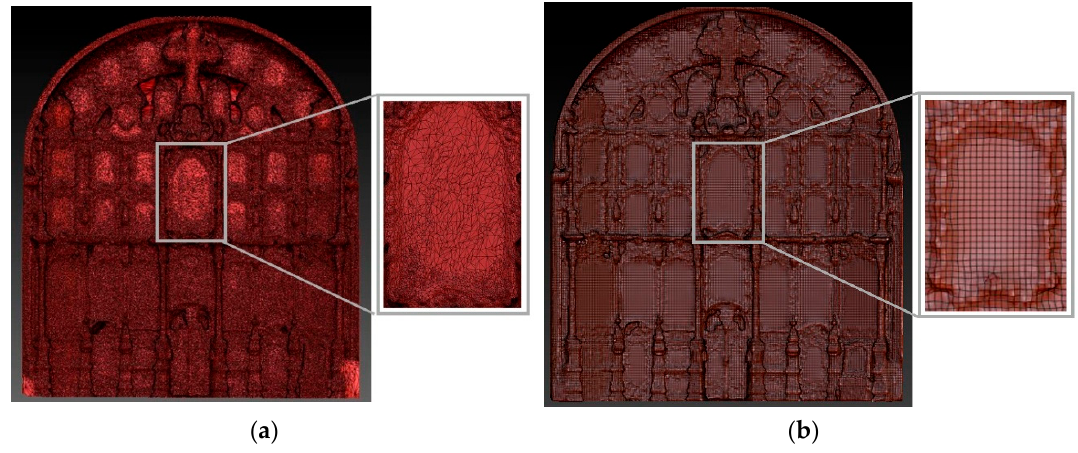
Figure 3. (a ) High-poly 3D model of the iconostasis and the detail of the polygon mesh; ( b ) Low-poly 3D model obtained by optimization and retopology and the detail of the quadrilateral polygon mesh.